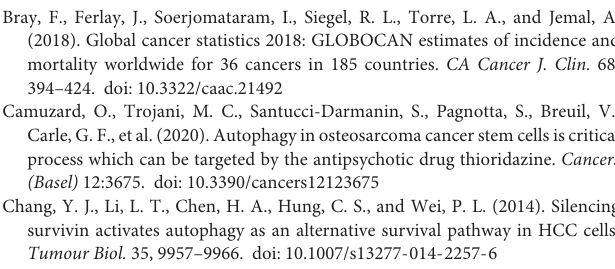
Supplementary Figure 1 | Quality control result of Smart-seq2 data related to HCC CSCs. (A,B) Gene counts of single-cell and pooled-cell samples using different classification. (C,F) Correlation analyses between gene counts and sequencing depth. (D,E) Sequencing depth of single-cell and pooled-cell samples using different classification. Supplementary Figure 2 | Characterization of single-cell RNA sequencing from 130 cells. (A) UMAP plot of different clusters of single-cell and pooled-cell samples. (B) UMAP plot of various pooled cell number of each sample. (C) UMAP plot of detailed information of each sample. (D) Top 5,000 variable genes were used for dimensional reduction analysis. (E) Elbow plot of 20 principal components. (F) Estimated P -value for principal components. Supplementary Figure 3 | Correlation analysis among 10 hub genes and three CSC markers in ICGC database. Only significant ones were showed. Supplementary Figure 4 | Correlation analysis among 10 hub genes and three CSC markers in TCGA database. Only significant ones were